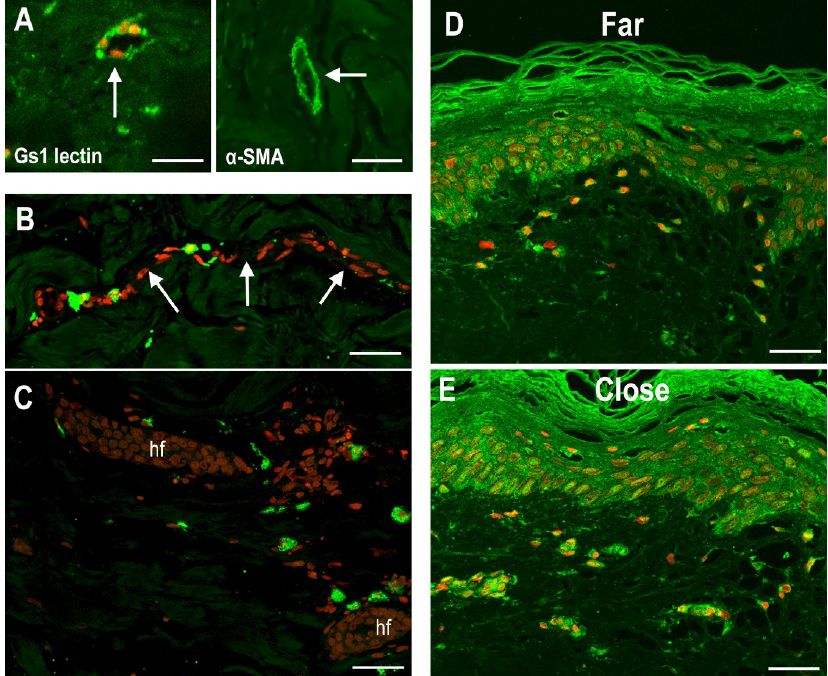
Figure 8. ( A ) Small blood vessels in the upper dermis (arrows) labeled by FITC-conjugate UEA lectin and anti- α -SMA antiserum. Mast cells, labeled by FITC-conjugated avidin, are located along blood vessels (arrows) ( B ) and around hair follicles (hf) ( C ). Visually, those located in proximity to the wound appeared to contain fewer fluorescent granules, suggesting that cell activation and granule release had occurred. ( D , E ) Dermal fibroblasts expressing the activation marker HSP47 appear to be more numerous in tissue areas close to the wound. HSP47 is also expressed by epidermal keratinocytes. Nuclei are counterstained in red with propidium iodide; bars = 100 µm.